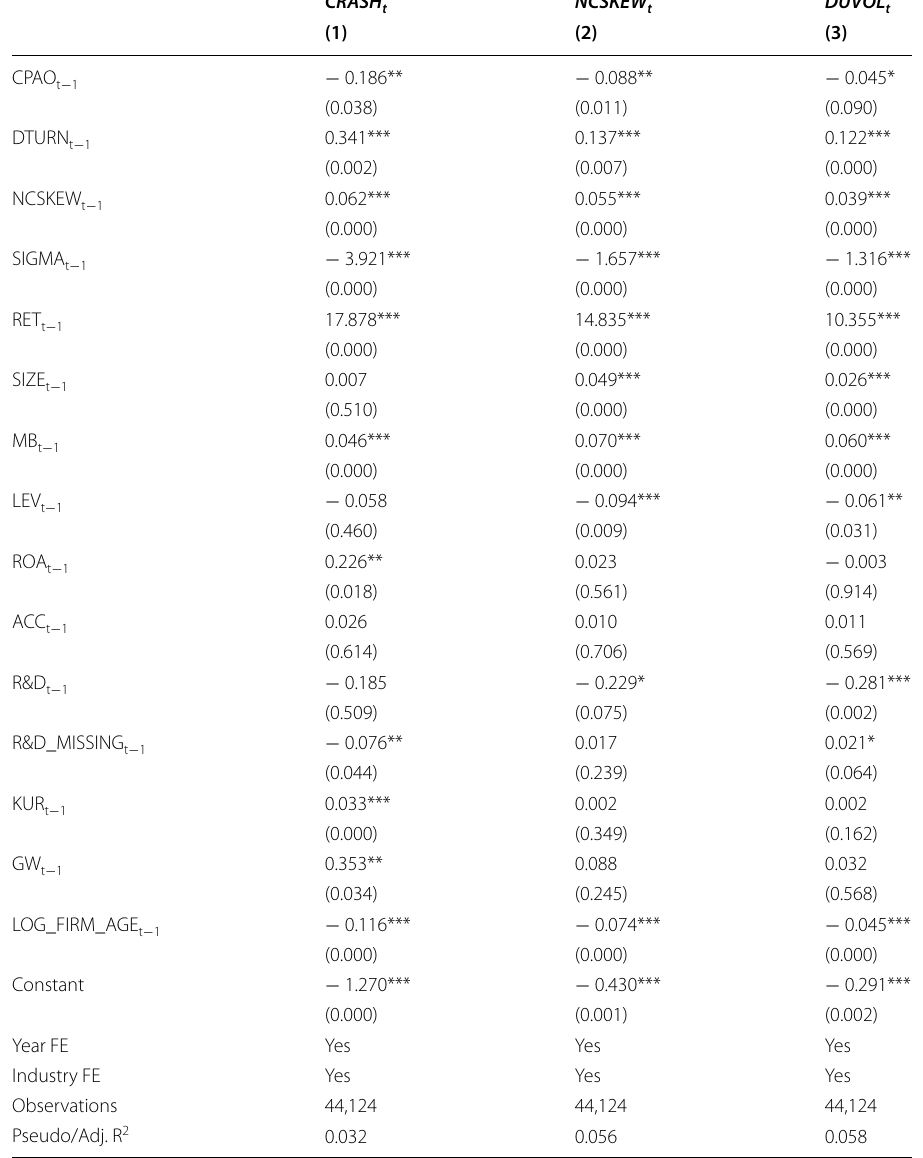
Table 4 Propensity score